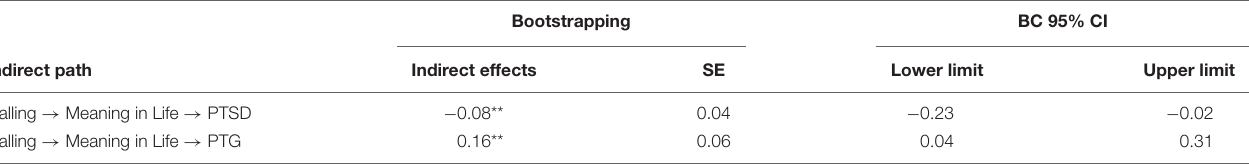
FIGURE 2 | Structural model of calling, meaning in life, PTSD, and PTG. TABLE 3 | Standardized indirect path coefficients and bootstrapping